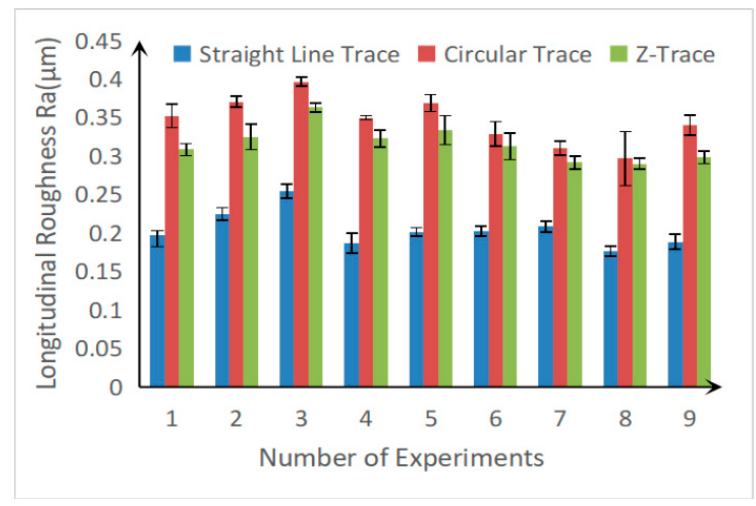
Figure 13. Comparison of longitudinal Ra values in the three different grinding tracks.